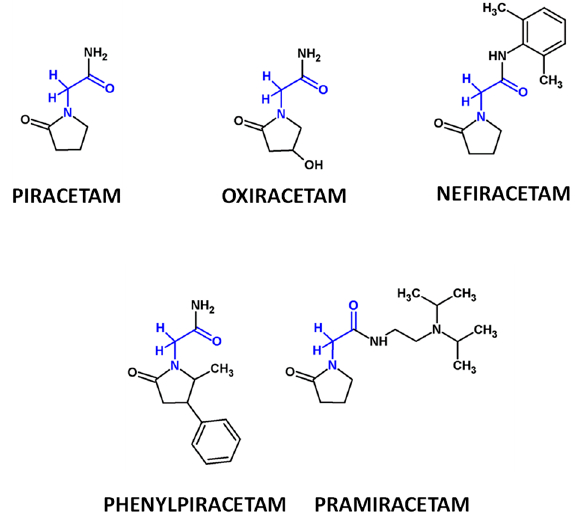
Figure 16. Schematic presentation of different racetams. N -substituted glycine moiety with α -C hydrogen atoms able to undergo hydrogen-deuterium exchange under basic conditions is marked in blue. in